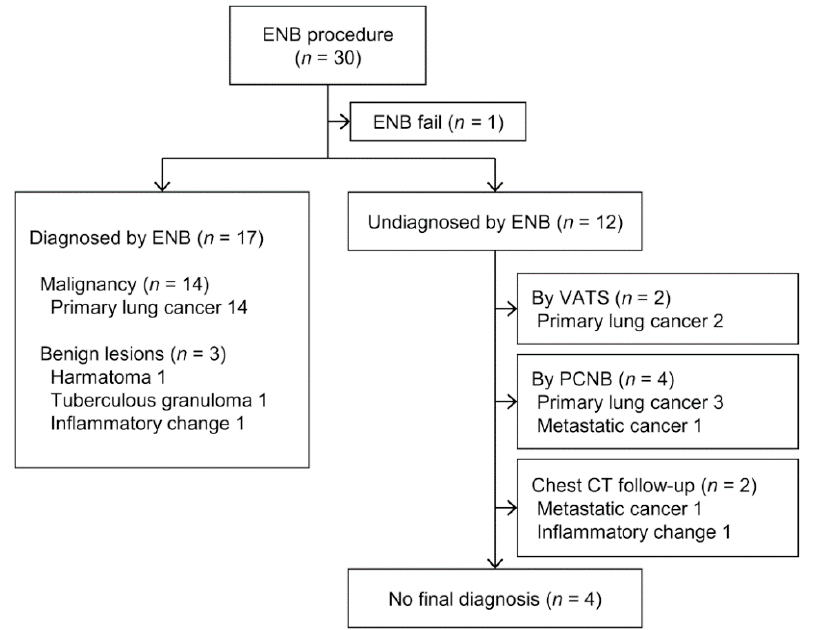
Figure 1. Flow diagram for 30 electromagnetic navigation bronchoscopy (ENB) cases and the final pathological results.